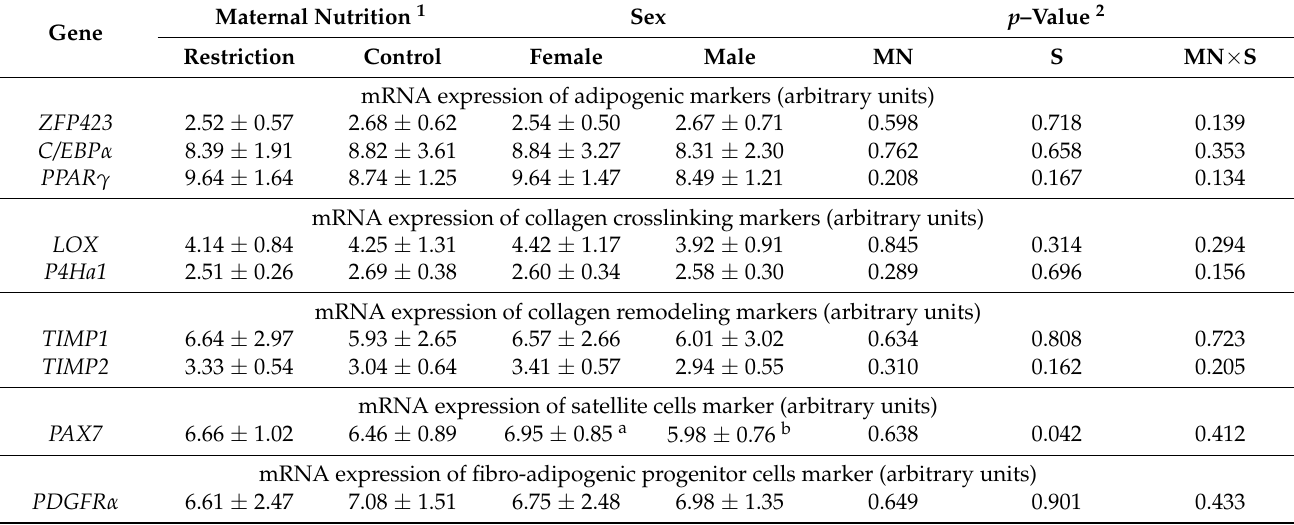
Table 4. Least square means ± standard errors for mRNA expression of adipogenic, collagen crosslinking, collagen remodeling, satellite cells, and fibro-adipogenic progenitor cells marker evaluated on the skeletal muscle of the 450d offspring (finishing phase) according to maternal nutrition and